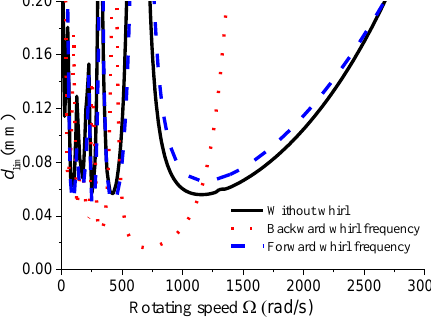
Figure 13. The influence of rotating.